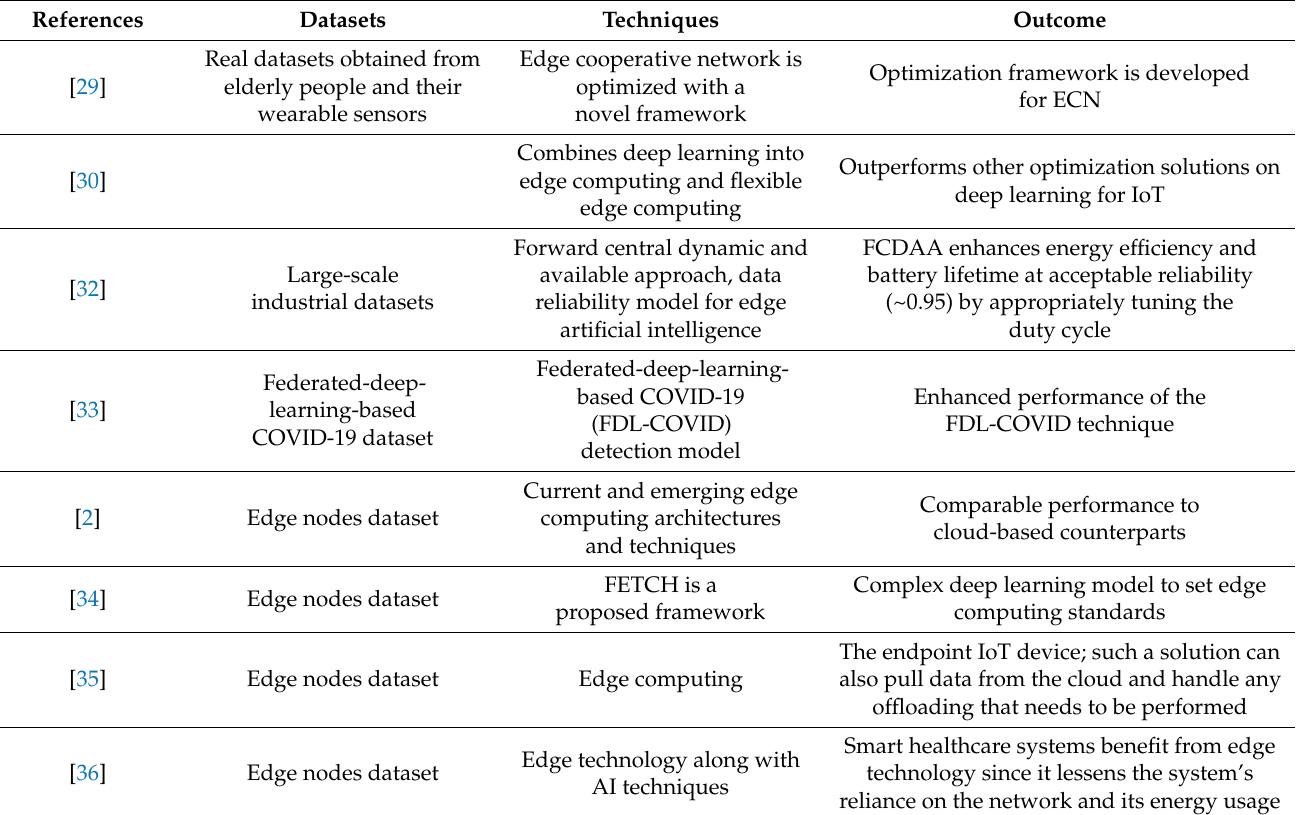
Table 1. Comparative